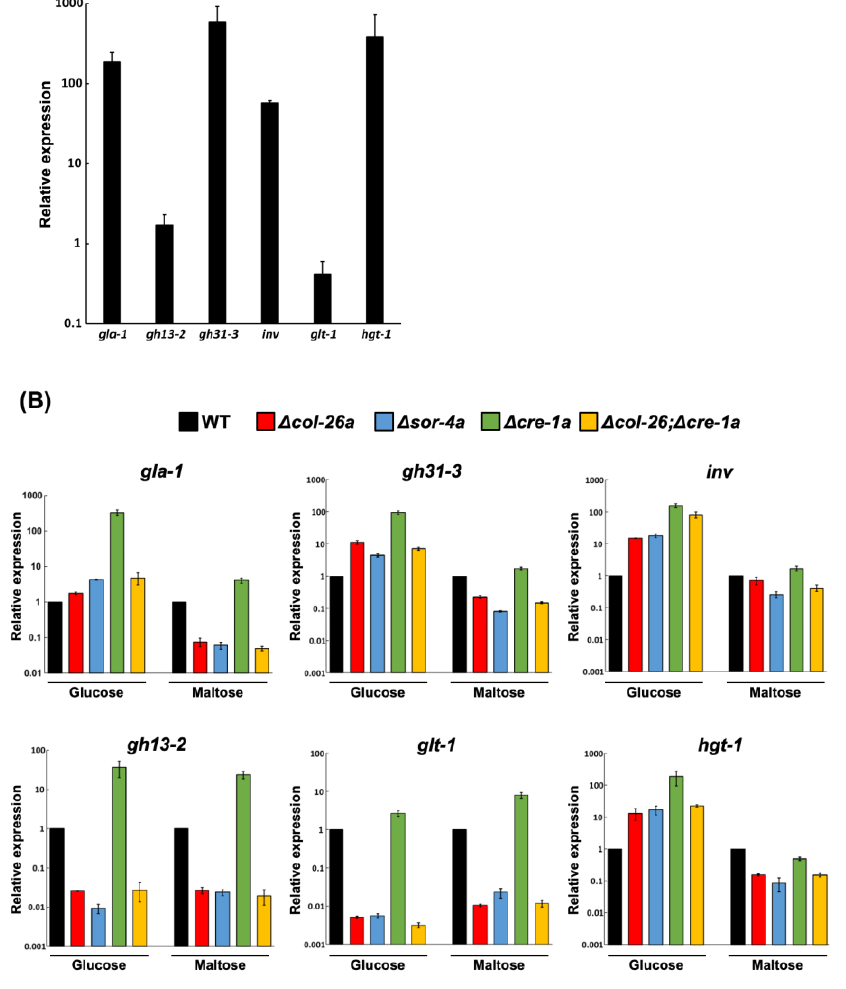
Figure 5. Gene expression analysis of the col-26 , sor-4 , cre-1 and cre-1 ; col-26 mutants. ( A ) Gene upregulation in the wild-type strain under glucose derepression conditions shifted from 1.2% glucose medium to 1.2% maltose medium (see Materials and Methods). Six genes, gla-1 (glucoamylase), gh13-2 (alpha-amylase), gh31-3 (alpha-glucosidase), inv (invertase), glt-1 (low-affinity glucose transporter), and hgt-1 (high-affinity glucose transporter) were selected as target genes for qPCR analysis. With the exception of gh13-2 and glt-1 , all genes were highly upregulated in maltose medium. ( B ) Comparison of gene expression patterns in the Δ col-26a , Δ sor-4a, Δ cre-1a and Δ col-26 ; Δ cre-1a mutants. Expression levels in each mutant strain were calculated relative to the wild-type strain grown under glucose-rich conditions (Glucose) and glucose derepression conditions (Maltose). Errors are expressed as the standard error. At least three biological replicates of each experiment were performed.